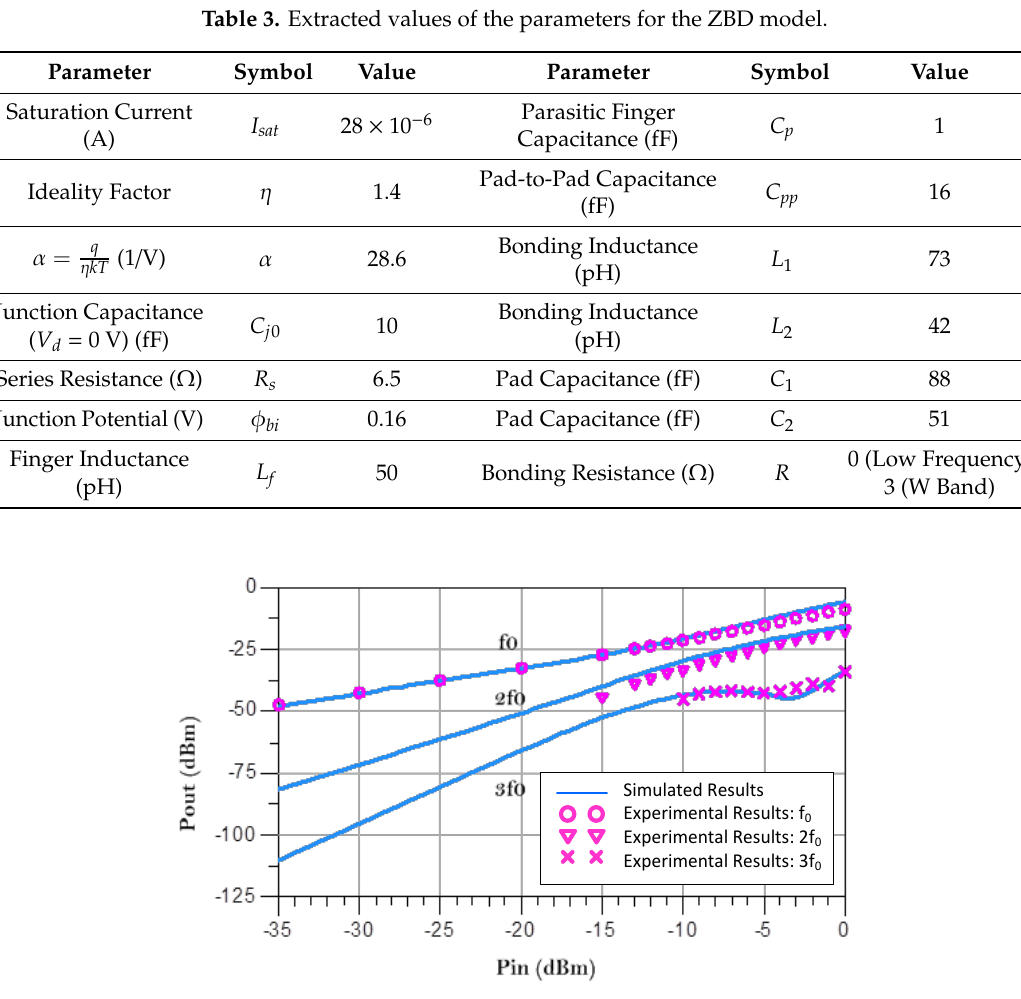
Figure 9. Simulated (continuous line) and measured output power versus input power. (Circles: f 0 , Inverted Triangle: 2f 0 , Cross: 3f 0 ).